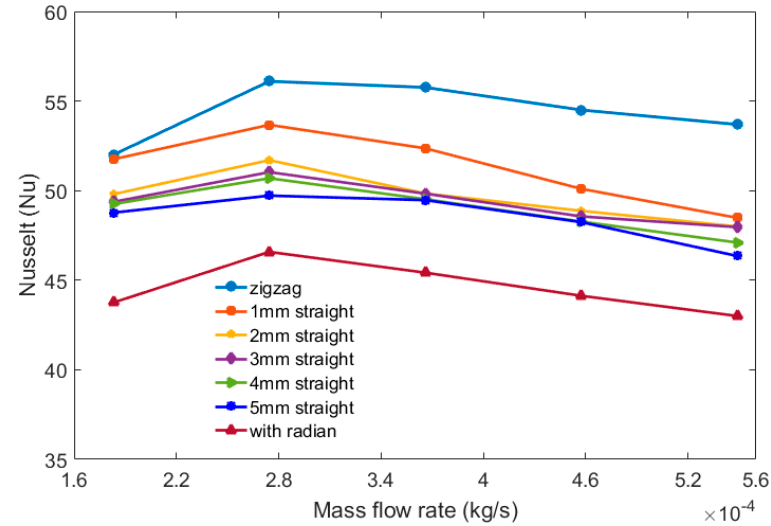
Figure 11. Nu of different channel shapes at different mass flow rates. Figure 11. Nu of di ff erent channel shapes at di ff erent mass flow